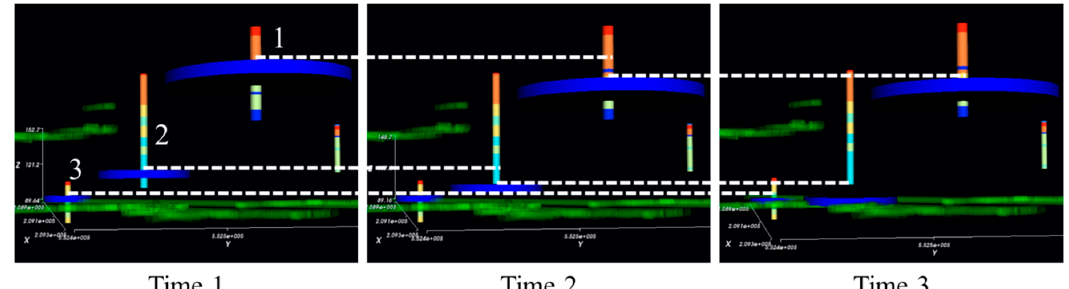
Figure 7. 3D visualization of groundwater change by using the time step slider in the SIMPL program.